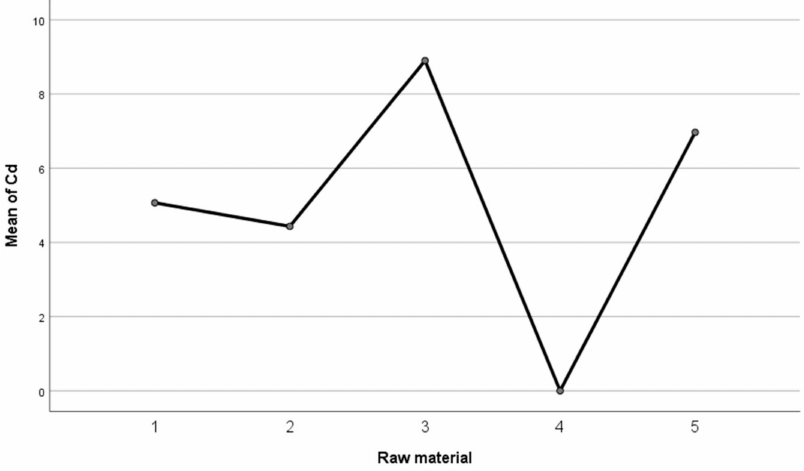
Figure 4. Average comparison for